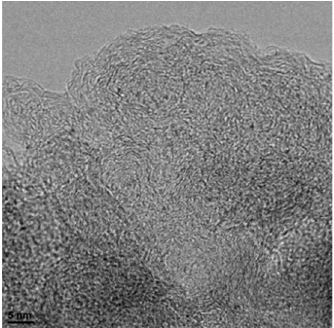
Figure 5. TEM image of catalyst Ru-T.